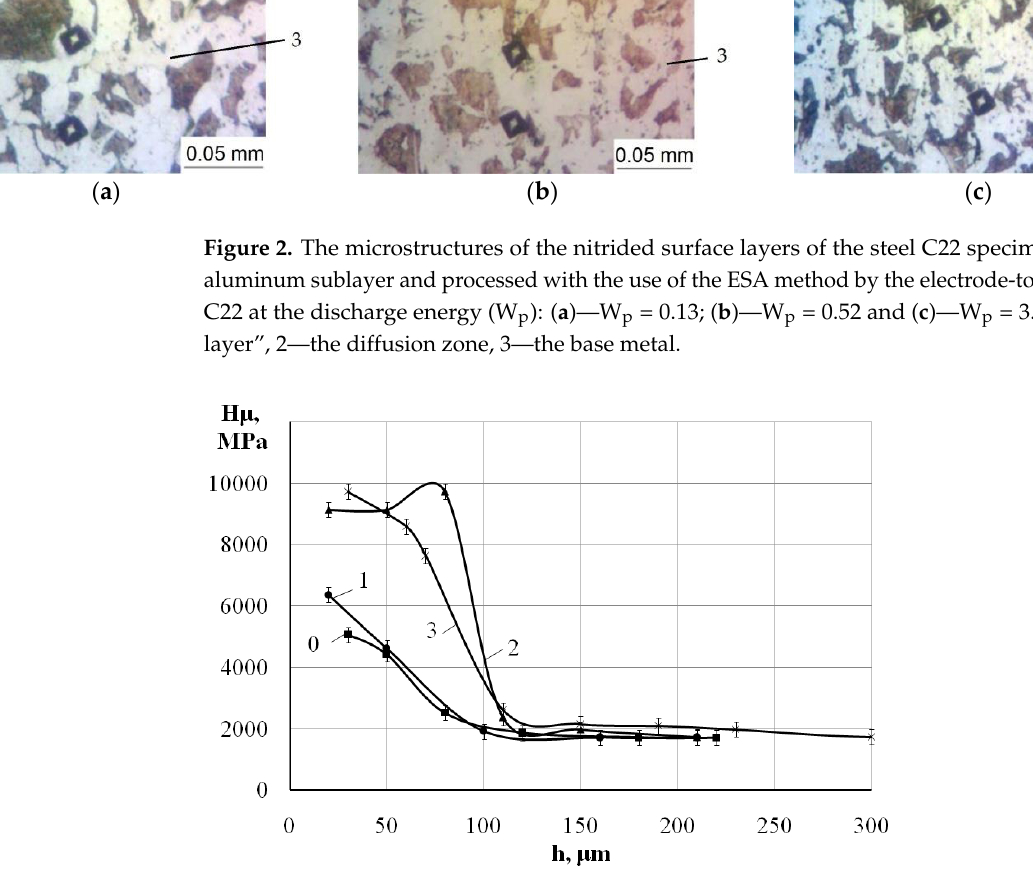
Figure 3. The distribution of the micro hardness over the depth of the layer, beginning from the surface of the specimen made of steel C22: 0 — the ESA process by aluminum at W p = 3.40 J; after nitriding process with the use of the nitrogen-containing paste and alloying by the electrode-tool made of steel C22 at the discharge energy (W р ): 1 — W р = 0.13; 2 — W р = 0.52, and 3 — W р = 3.4 J.